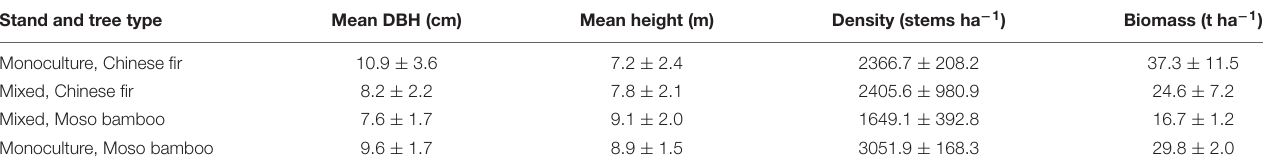
TABLE 1 | Stand and average tree characteristics in moso bamboo and Chinese fir monocultures and a mixed stand. Stand and tree